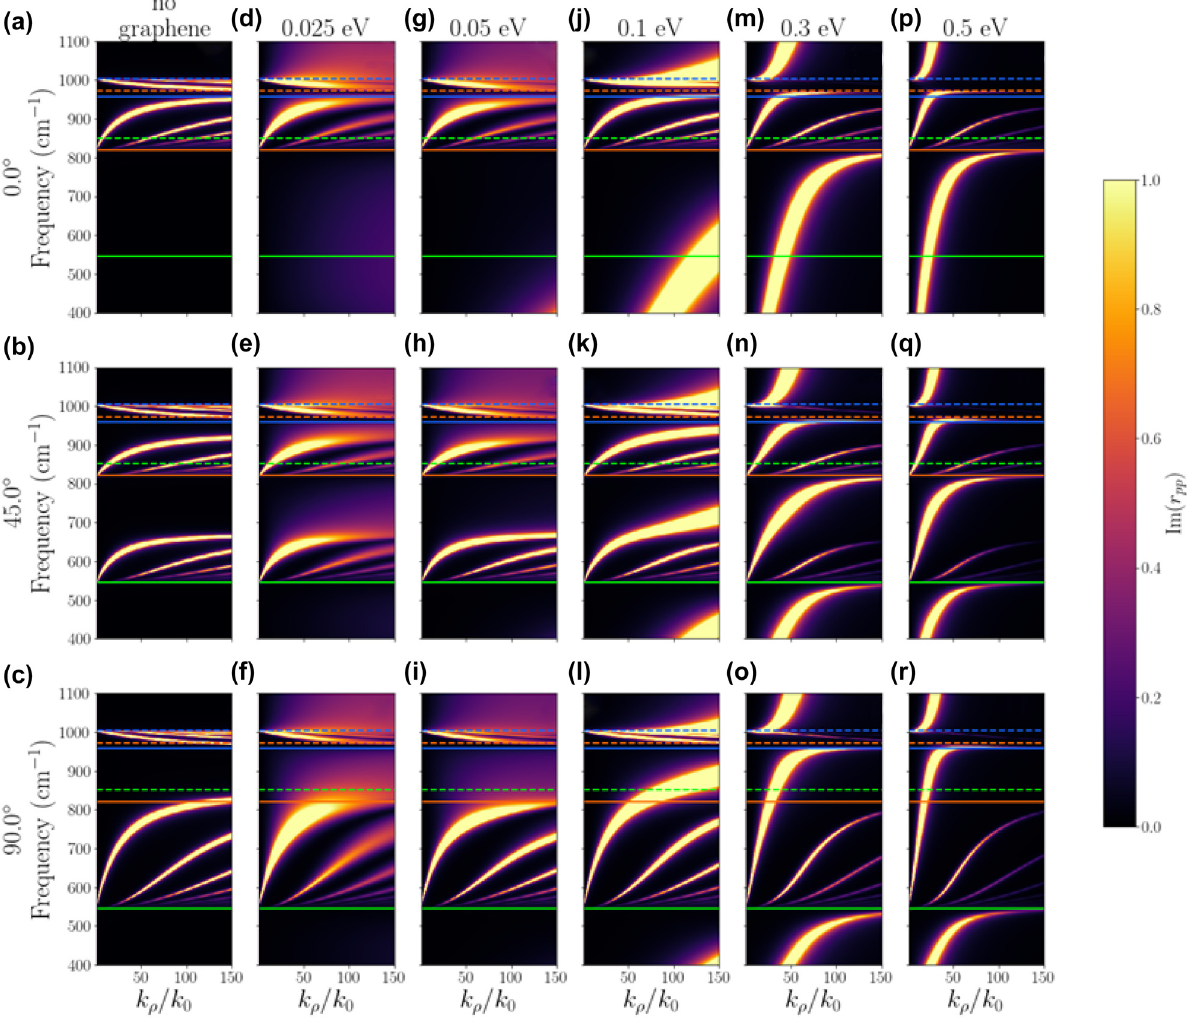
Figure 2: Dispersionof polaritonic modesin air/graphene/ α -MoO 3 (50nm)/Siheterostructure as a functionof ϕ and chemicalpotential( μ ) of graphene. Dotted lines indicate LO phonon frequencies, and solid lines indicate TO phonon frequencies along y -(green), x -(orange) and z -(blue) crystallographic directions of α -MoO 3 . The color axis represents imaginary part of unitless quantity Fresnel ’ s re fl ection coef fi cient for p-polarized